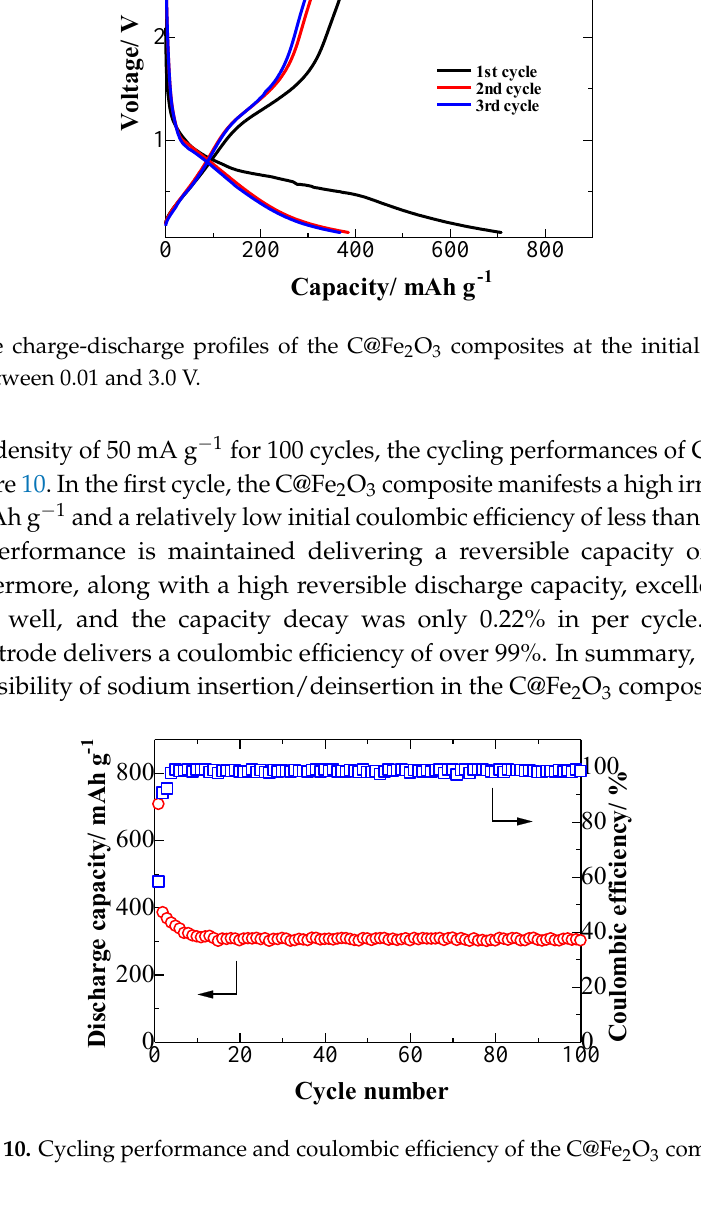
Figure 8. Cyclic voltammetry (CV) curve of the C@Fe 2 O 3 composite at the initial cycle.